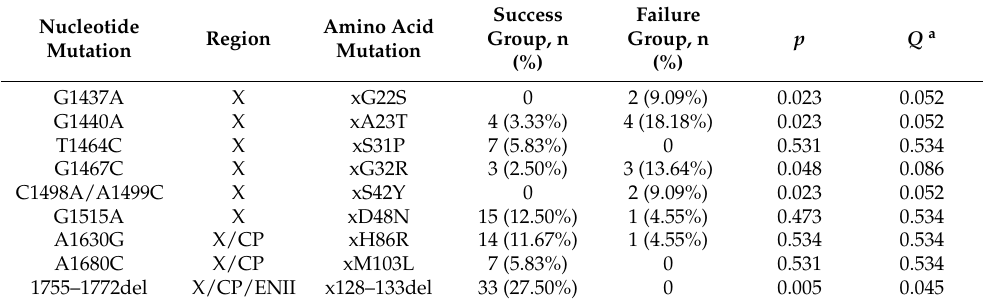
Table 2. The mutations of the HBV X region in the immunoprophylaxis failure and success groups. Nucleotide Amino Acid Region Mutation